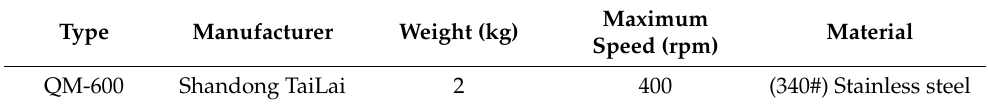
Table 1. Parameters of QM-600 swirl natural ventilator.